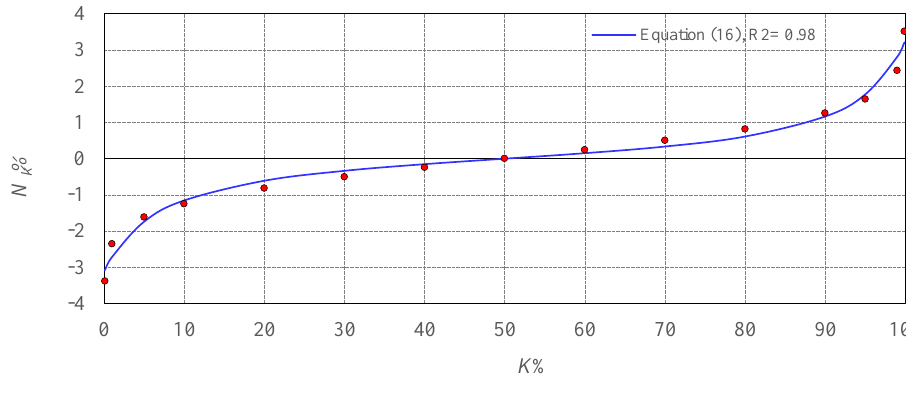
Figure 9. Proposed relationship for the coefficient N k% .